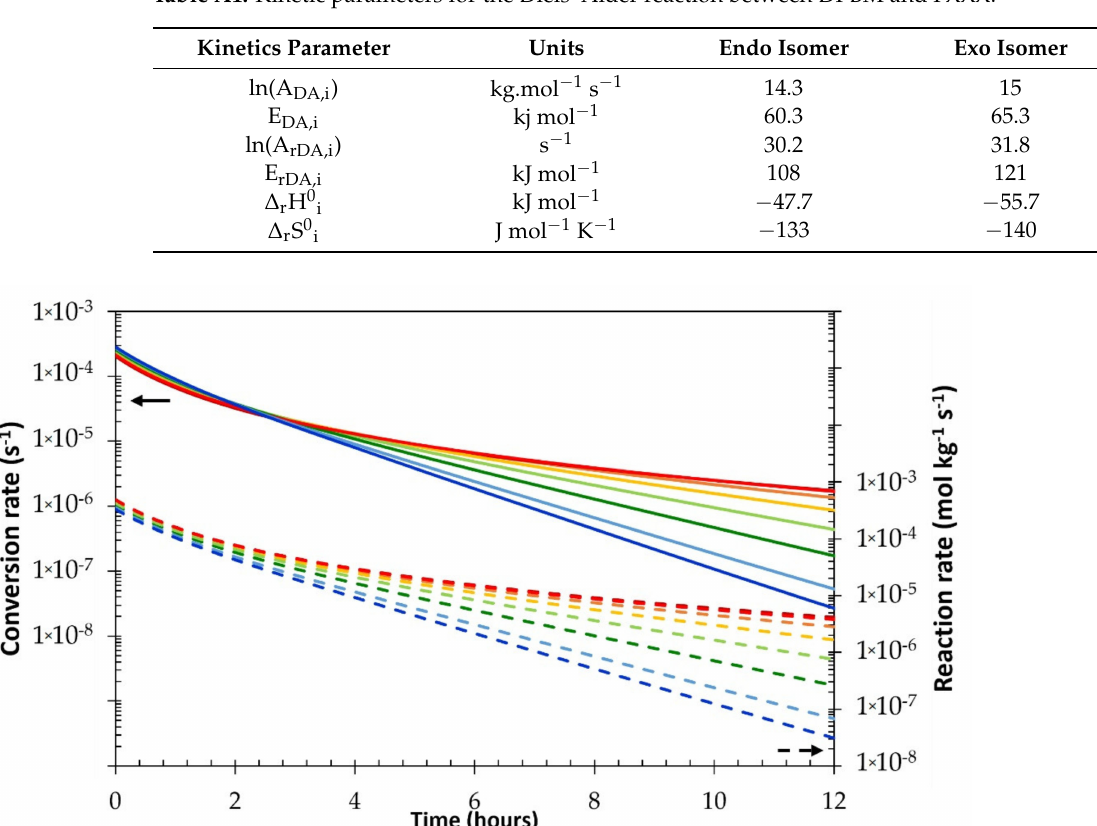
Figure A1. Diels–Alder conversion rate (solid lines) and reaction rate (dashed lines) for the DPBM-F400 reversible polymer network with different stoichiometry as a function of time at 25 ◦ C: DPBM-F400( r = 1) red, ( r = 0.8) orange, ( r = 0.7) yellow, ( r = 0.6) green, ( r = 0.5) light blue, and ( r = 0.4) dark